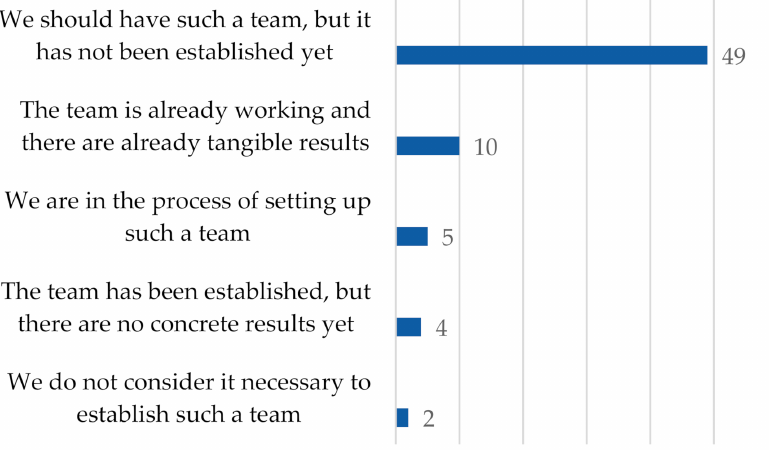
Figure 4. The team responsible for implementing Industry 4.0 technology into the